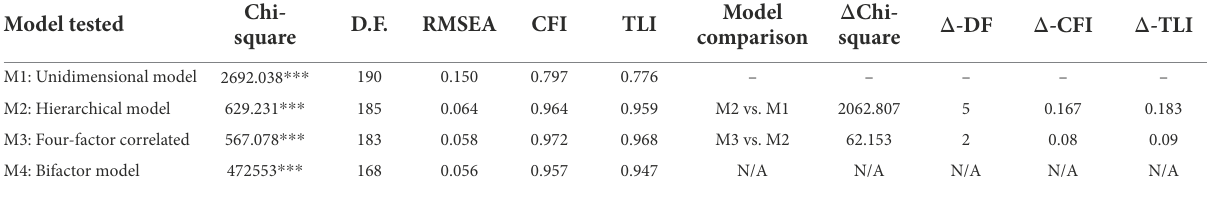
TABLE 1 Model comparison in search of the optimal structure of Logometro. Model